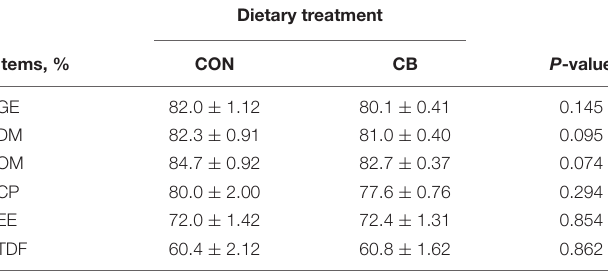
TABLE 2 | The effect of dietary corn bran on nutrient digestibility in weaned pigs. Dietary treatment Items, %